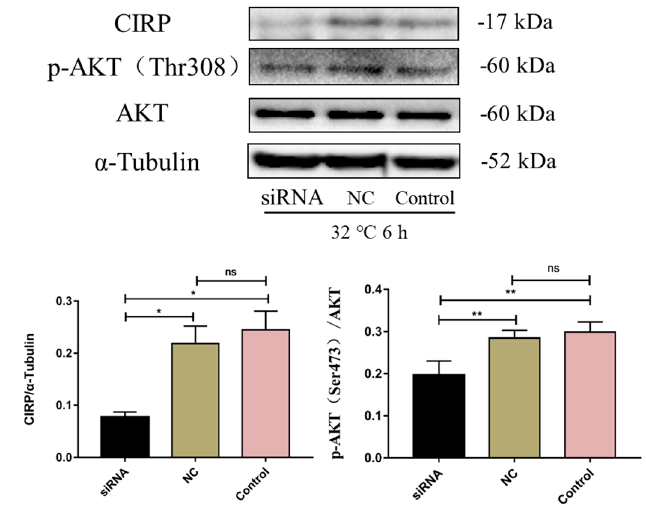
Figure 9. Effect of CIRP silencing on the level of protein kinase B (AKT) protein and phosphorylation status (Thr308) in C57BL/6 mouse livers. The data are presented as the mean ± SEM ( n = 8). Statistically significant differences are indicated; * p < 0.05 and ** p < 0.01.